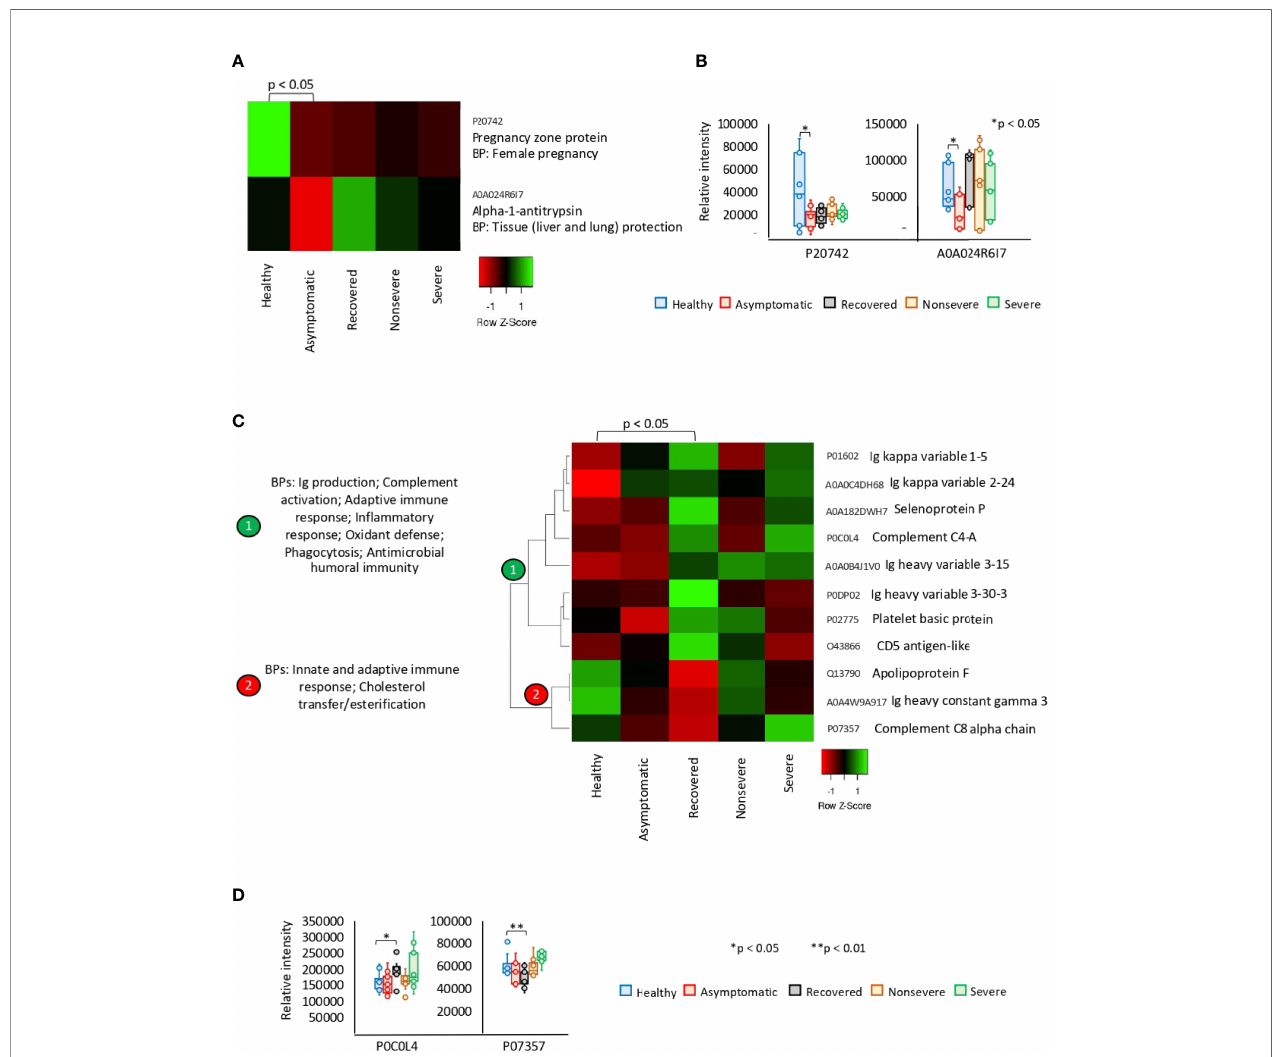
FIGURE 2 | Exclusive differential representation of proteins in sera from COVID-19 asymptomatic and recovered cases. (A) Heatmap of proteins signi fi cantly dysregulated ( Z -scored original value) in asymptomatic cases only ( p < 0.05; unpaired two-sided Welch ’ s t -test). Biological process (BP) is shown for each protein. (B) Change in levels of two selected proteins with signi fi cant differences between asymptomatic cases and healthy controls (* p < 0.05; unpaired two-sided Welch ’ s t -test). (C) Heatmap of proteins signi fi cantly dysregulated ( Z -scored original value) in recovered cases only ( p < 0.05; unpaired two-sided Welch ’ s t -test). Biological processes (BPs) are shown for each cluster of proteins differentially represented in response to COVID-19 (cluster 1, overrepresented; cluster 2, underrepresented). (D) Change in levels of two selected proteins with signi fi cant differences between recovered cases and healthy controls (* p < 0.05, ** p < 0.01; unpaired two-sided Welch ’ s t